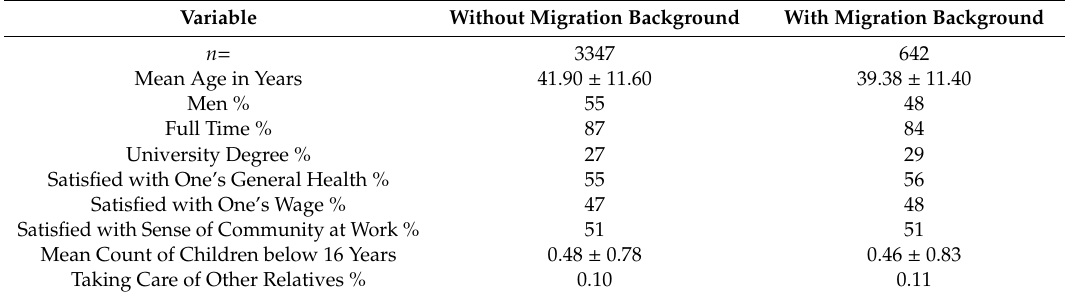
Table 1. Descriptive statistics of the employees without ( n = 3347) and with a migration background